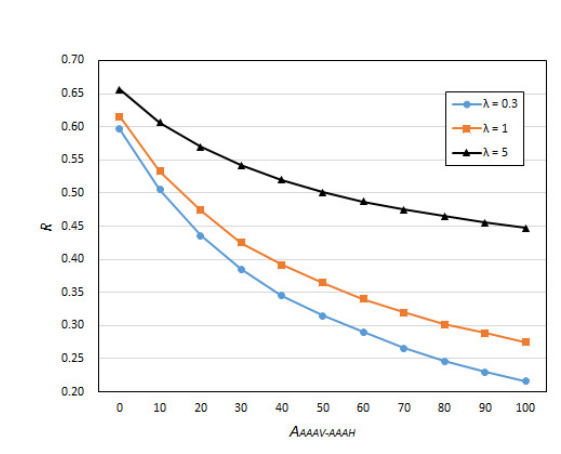
Figure 9. Signaling overhead ( l